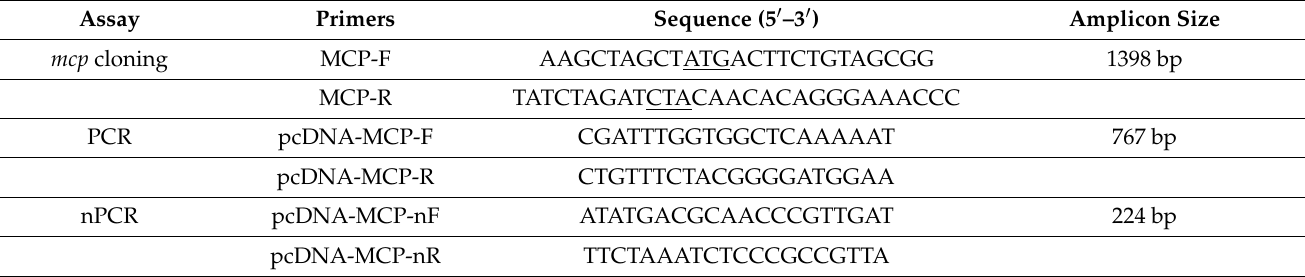
Table 1. Primers designed for DNA vaccine construction and